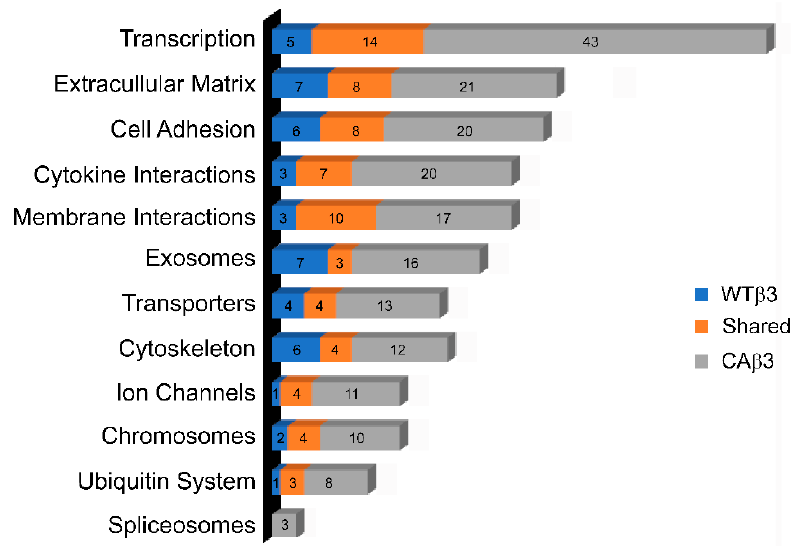
Figure 3. More biological processes were affected by overexpressing CA- α v β 3 integrin than WT- α v β 3 integrin. Biological processes that were enriched in CA β 3 or WT β 3 cells were identified